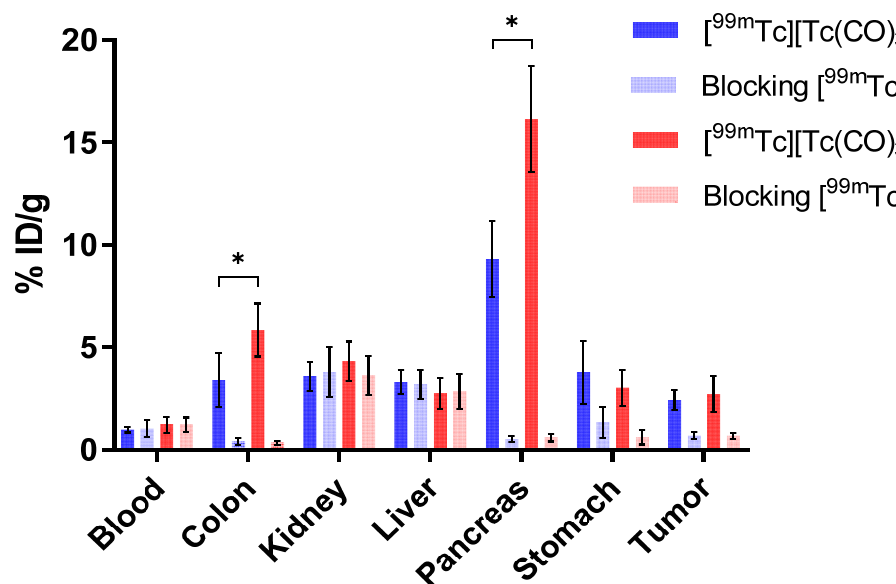
Figure 4. Biodistribution of radiolabeled bombesin derivatives [ 99m Tc][Tc(CO) 3 ( 12 )] and [ 99m Tc][Tc(CO) 3 ( 13 )] under blocking conditions in selected organs and tumors of mice bearing PC-3 cell xenografts at 1 h p.i. ( n = 5–6); results are expressed as the percentage of injected dose per gram of tissue (%ID/g); error bars indicate standard error of the mean; * indicates α < 0.05.